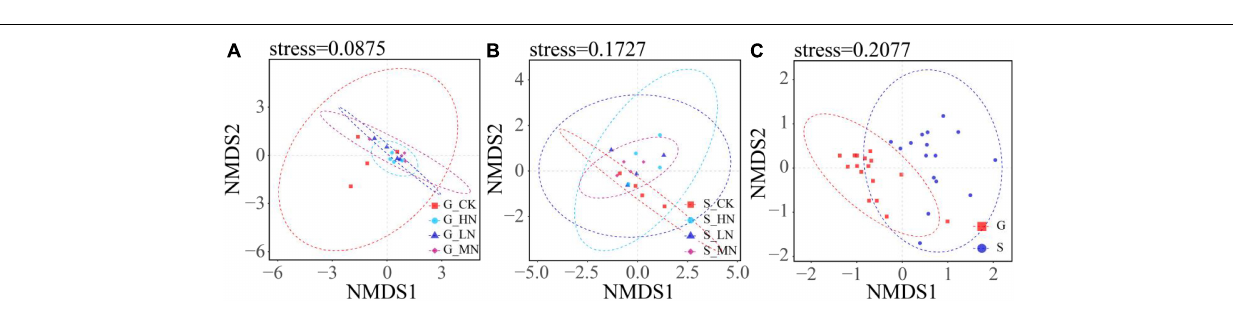
FIGURE 6 | NMDS analysis of OTU level ( A , groups of nitrogen addition on gentle slope; B , groups of nitrogen addition on steep slope; C , groups of gentle slope and steep slope). If the soils in the same group are in a circle, it means that the difference between groups is not obvious, and the non-intersection of circles between groups means that there is a certain difference between the